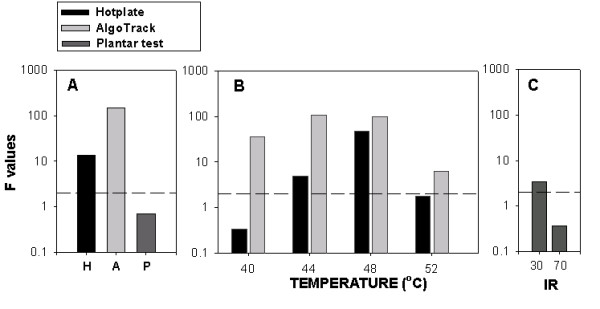
Comparing detection of thermal sensitivity changes between Plantar, Hotplate, and AlgoTrack tests in SNI rats (F-values in ANOVA planned comparisons). A) F-values for contrasting thermal pain behavior pre-ligation (3 days prior) to post-ligation (days 7, 17 and 24) on the Plantar test (P; for both 30 and 70 IR intensities); on the Hotplate test (H; for all test temperatures: 40, 44, 48, 52°C); and on the AlgoTrack test (for the same test temperatures). B) F-values for contrasting between SNI rats and sham rats on AlgoTrack test (gray bars) and Hotplate test (black bars) in post-ligation days (7, 17 and 24), for each applied temperature indicated. C) F-values for contrasting between SNI rats and sham rats on Plantar test in post-ligation days, for the IR intensities indicated. The y-axis is in log scale and covers 4 decades. The dashed line is for F = 2.0, which delineates threshold for significance.